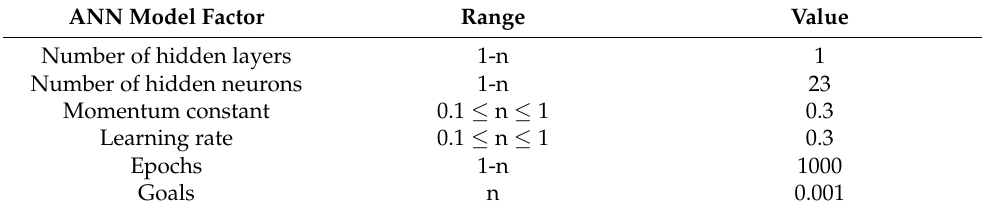
Table 4. ANN model